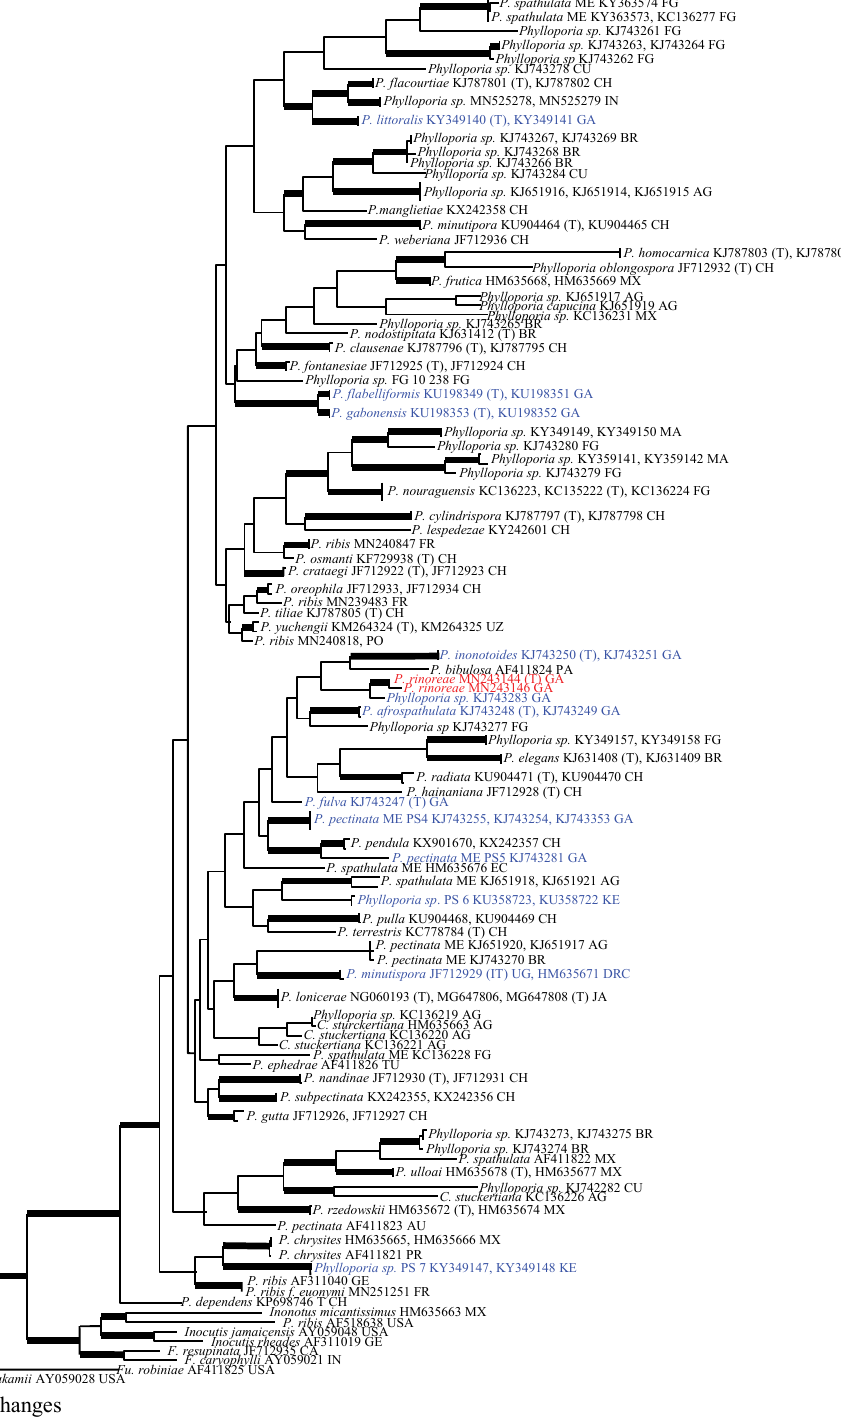
Figure 1 – Phylogenetic relationships of Phylloporia species inferred from nuc 28S rDNA sequences. The tree was rooted with Inonotus micantissimus MUCL52413. Thickened branches represent bootstrap value (MP, ML) and PP value greater than 90%/0.90. Names highlighted in blue represent species known from tropical Africa, in red = the new species P. rinoreae . Abbreviations used. AG = Argentina; AU = Australia; BR = Brazil; CH = China; CA = Cameroon; CU = Cuba; DRC = Democratic Republic of Congo; EC = Ecuador; FG = French Guiana; FR = France; GA = Gabon; GE = Germany; IN = India; JA = Japan; KE = Kenya; MA = Martinique; MX = Mexico; PA = Pakistan; PR = Puerto Rica; TU = Turkmenistan; UG = Uganda; USA = United States of America; UZ = Uzbekistan; (T) = Type specimen; ME = Morpho-ecological